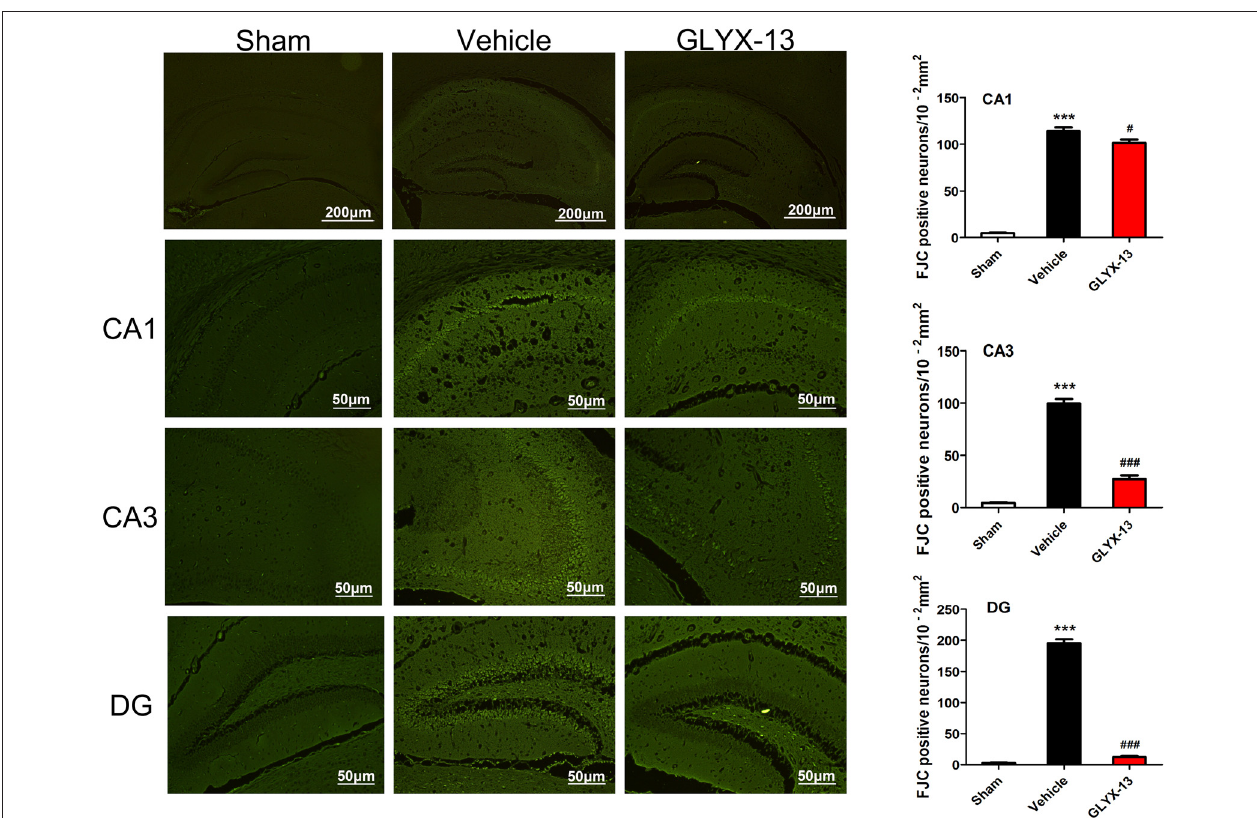
FIGURE 4 | Administration of GLYX-13 dramatically decreased the number of Fluoro Jade C (FJC) positive neurons in hippocampus. Three regions (CA1, CA3 and DG) were further evaluated to compare the FJC fluorescent signals between sham, vehicle and GLYX-13 treated group. Photomicrographs of FJC-stained three regions of interest were shown in each group. GLYX-13 treatment dramatically reduced the number of FJC positive neurons in DG and CA3 region ( ### p < 0.001) and also reduced the number of FJC positive neurons in CA1 ( # p < 0.05). The numbers of FJC positive neurons were expressed as the mean number per field of view. Data were expressed as mean ± SEM ( n = 5); one-way ANOVA and Newman-Keuls post test, ∗∗∗ p < 0.001, vs. Sham; ### p < 0.001, # p < 0.05, vs.